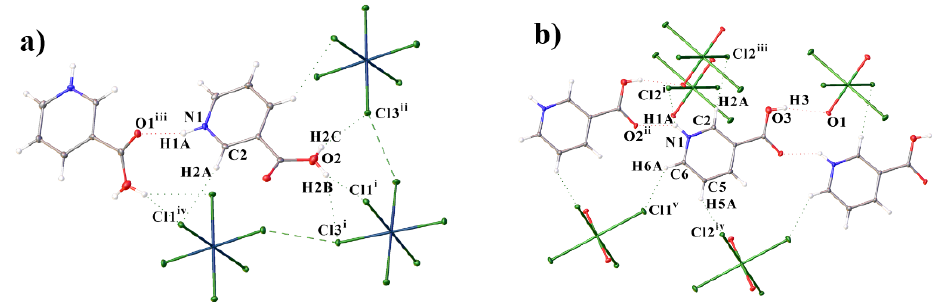
Figure 2. View showing the hydrogen and halogen bonds in I ( a ) [Symmetry codes: (i) − x +1, − y +1, − z +2; (ii) x − 1/2, − y +1/2, z +1/2; (iii) x − 1/2, − y +3/2, z − 1/2; (iv) 3/2 − x, 1/2+y, 3/2 − z.] and hydrogen bonds in II ( b ) [Symmetry codes: (i) x +1, y , z +1; (ii) x , y , z +1]. Both positions of the disordered hydrogen atom of carboxyl group in I are shown. Table 4. Hydrogen-bond geometry for I at 100 K (Å, °). Table 5. Hydrogen-bond geometry for II (Å, ◦ ).